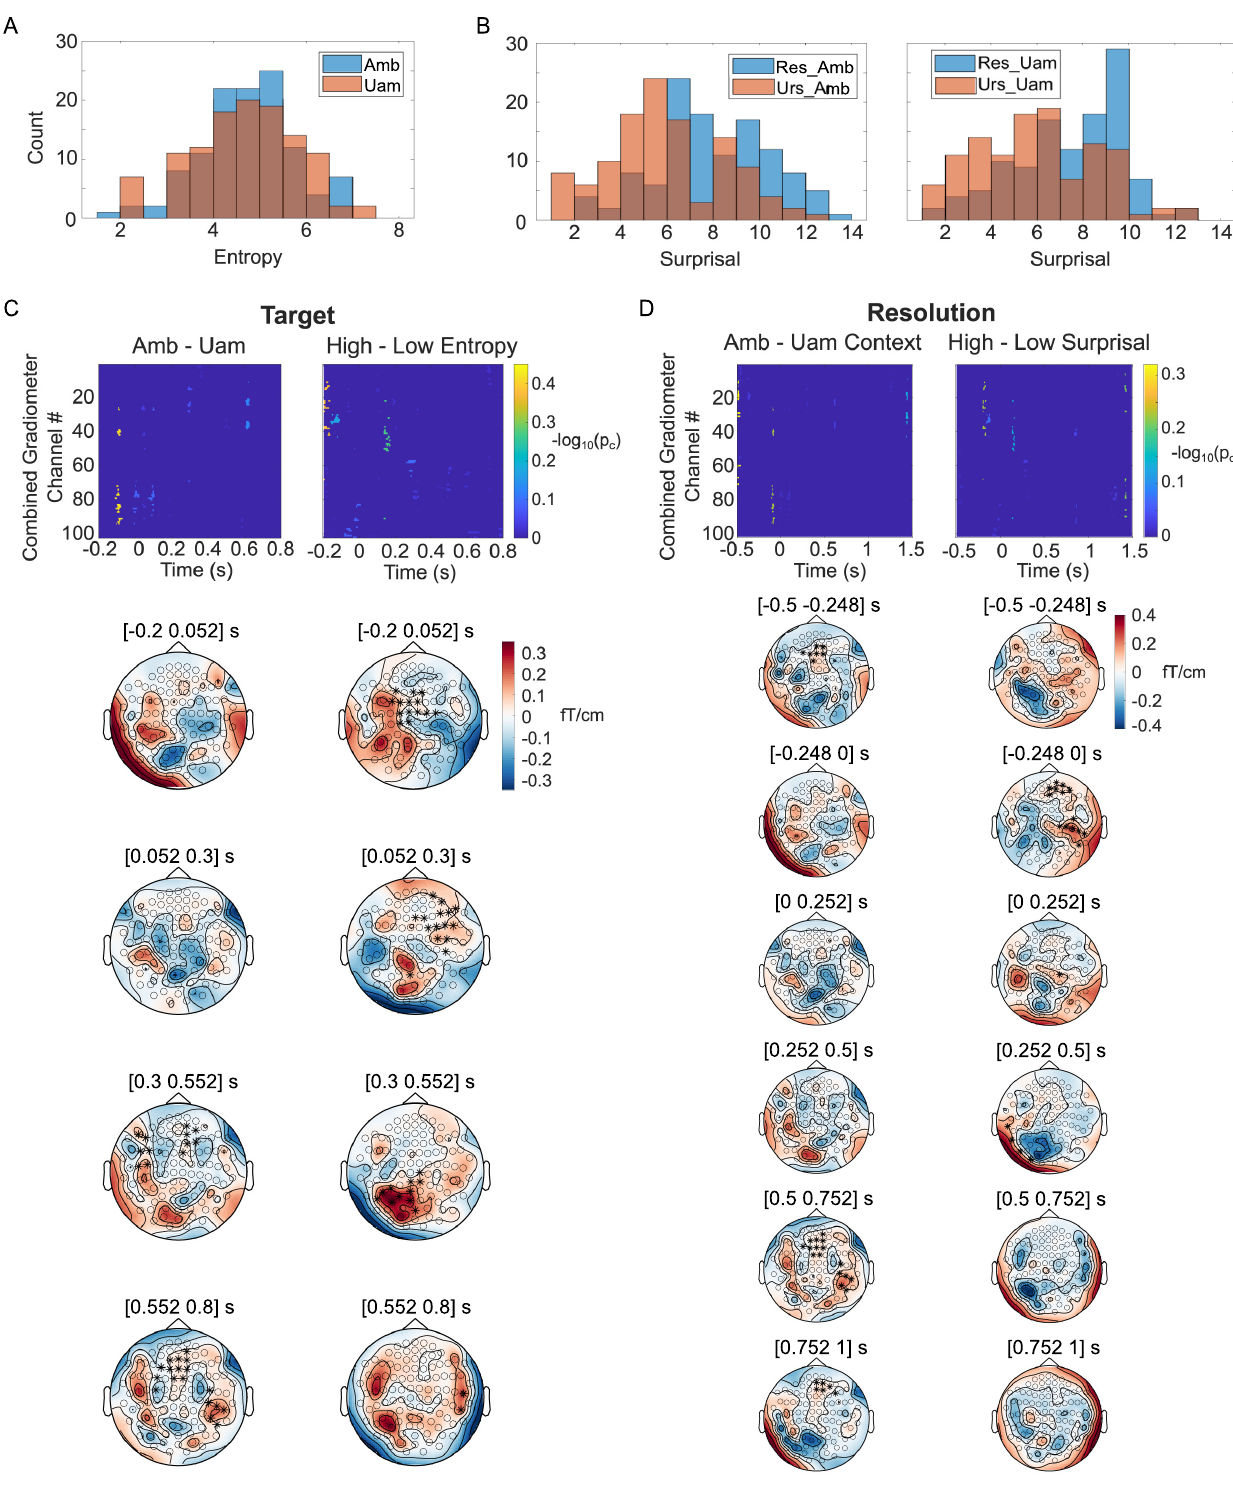
Fig 4. Effects of semantic properties and GPT-2 prediction statistics in MEG response to speech. (A) Distributions of Target entropy for ambiguous and unambiguous Targets in all 58 sentences. ( B ) Distributions of the surprisal values for Resolve (blue) and Unresolve (orange) Resolution words, following Ambiguous (left) or Unambiguous (right) Target words. ( C ) Statistical test results for the effect of semantic ambiguity (left column) and GPT-2 prediction entropy (right column) on MEG combined gradiometer data around the time of Target offset. Top row: sensor-time maps for significance level ( − log 10 (p c ))